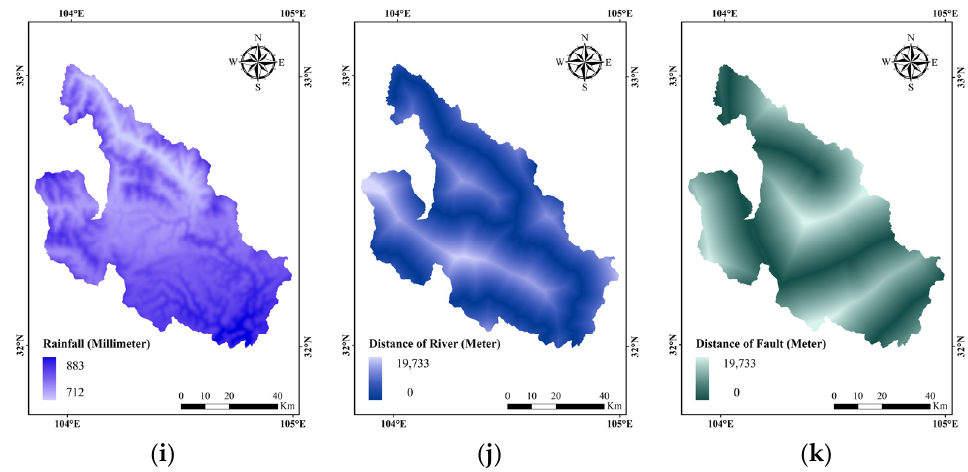
Figure 2. Landslide conditioning factors of LSM. ( a ) Elevation, ( b ) Slope, ( c ) Aspect, ( d ) Plan curvature, ( e ) Profile curvature, ( f ) Lithology, ( g ) NDVI, ( h ) Landcover, ( i ) Rainfall, ( j ) Distance to river and ( k ) Distance to fault.